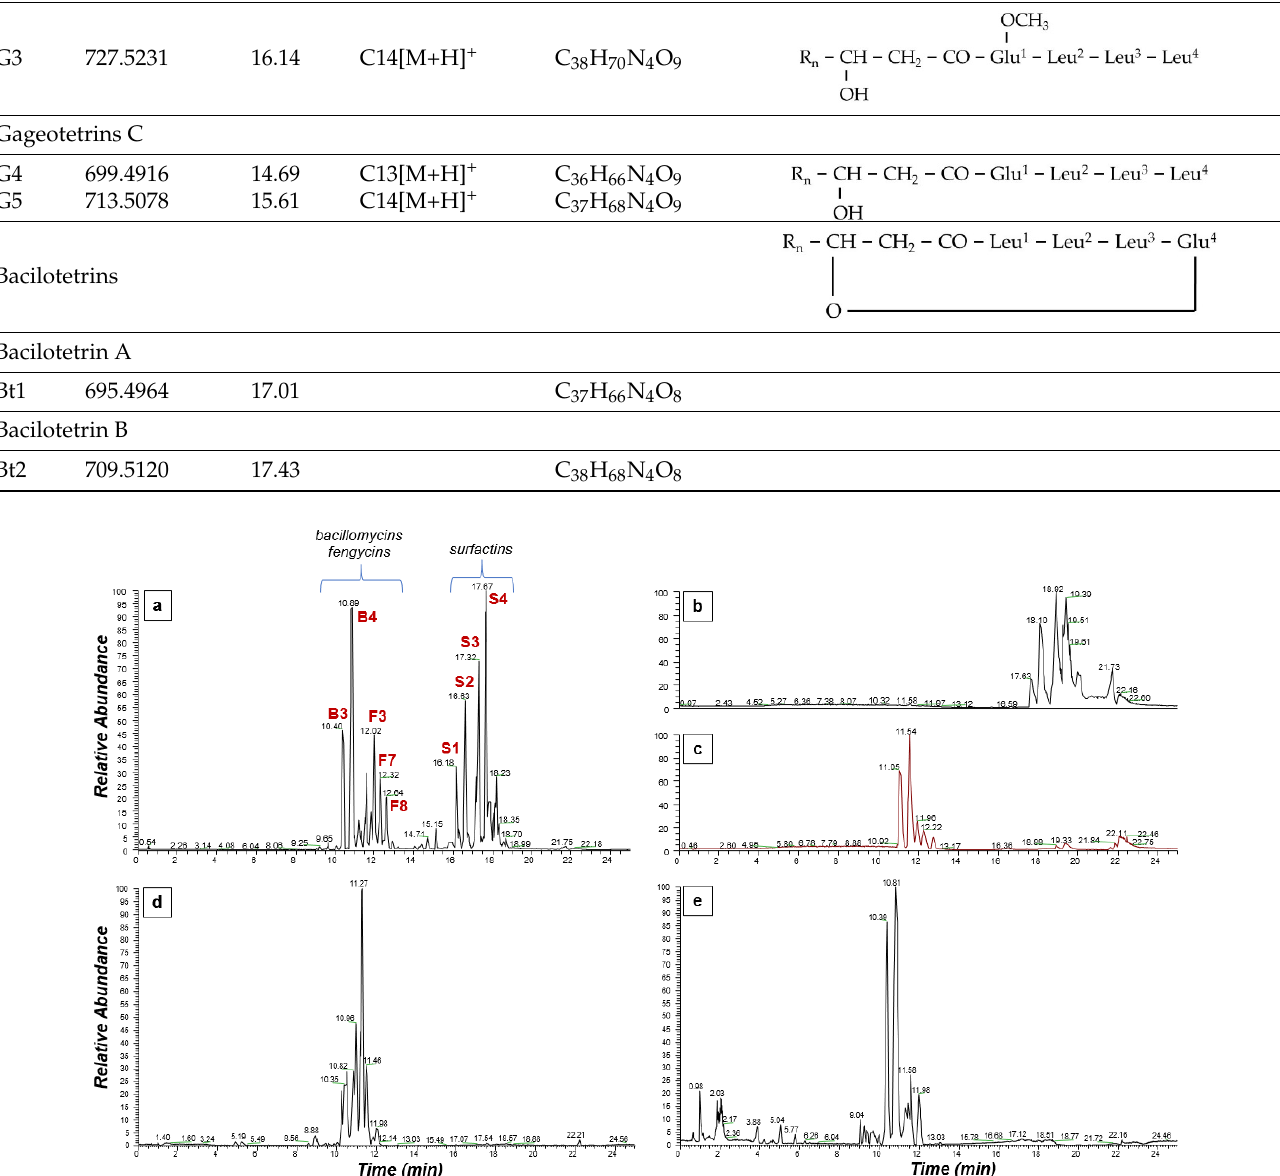
Figure 2. LC/ESI/MS total ion chromatograms (TICs) of Bacillus sp. PTA13 lipopeptides (LPs). TIC of ( a ) the total LP extract, ( b ) the surfactin-containing upper phase during liquid–liquid extraction, and ( c ) the corresponding lower phase that contains bacillomycins and fengycins, and the representative TIC of fractions derived from size-exclusion chromatography of the lower phase (see plot c) that contain ( d ) fengycins and ( e ) bacillomycins. Annotations of representative LPs are displayed (see Table